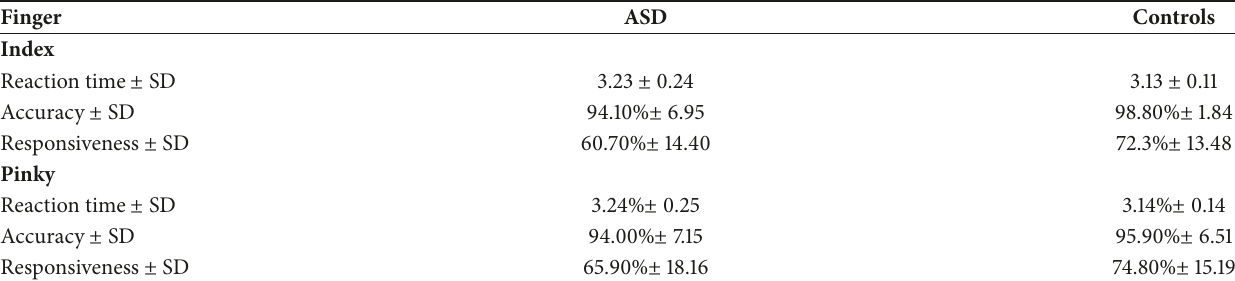
Table 2: Behavioral results.